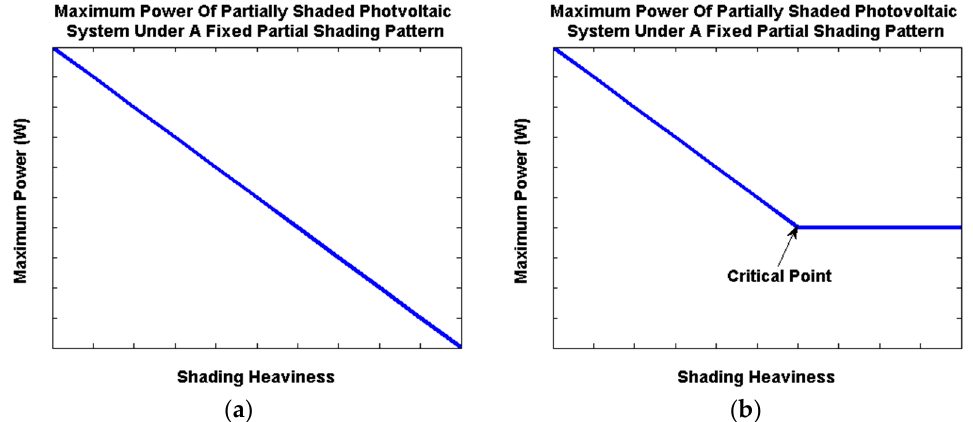
Figure 4. Maximum power of a partially shaded photovoltaic system under a fixed partial shading pattern ( a ) as suggested by the experimental results in [26]; ( b ) as suggested by the experimental results in [39].